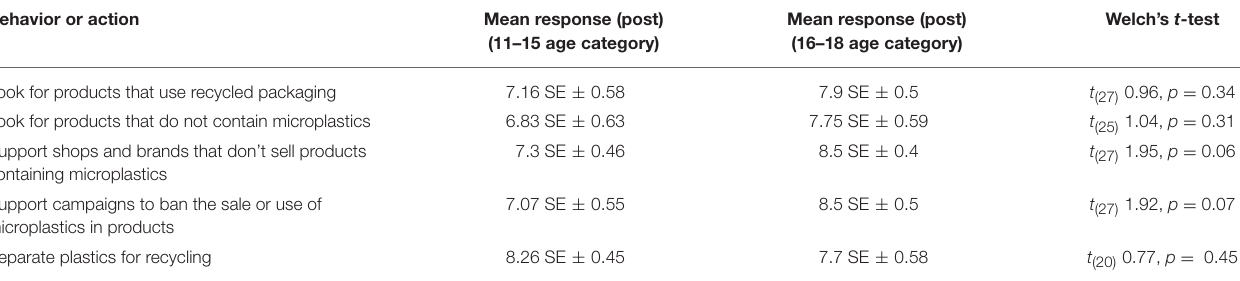
TABLE 9 | Mean intended frequency of each age group to undertake behavior options in the future, including Welch’s t -test of difference between groups. Behavior or